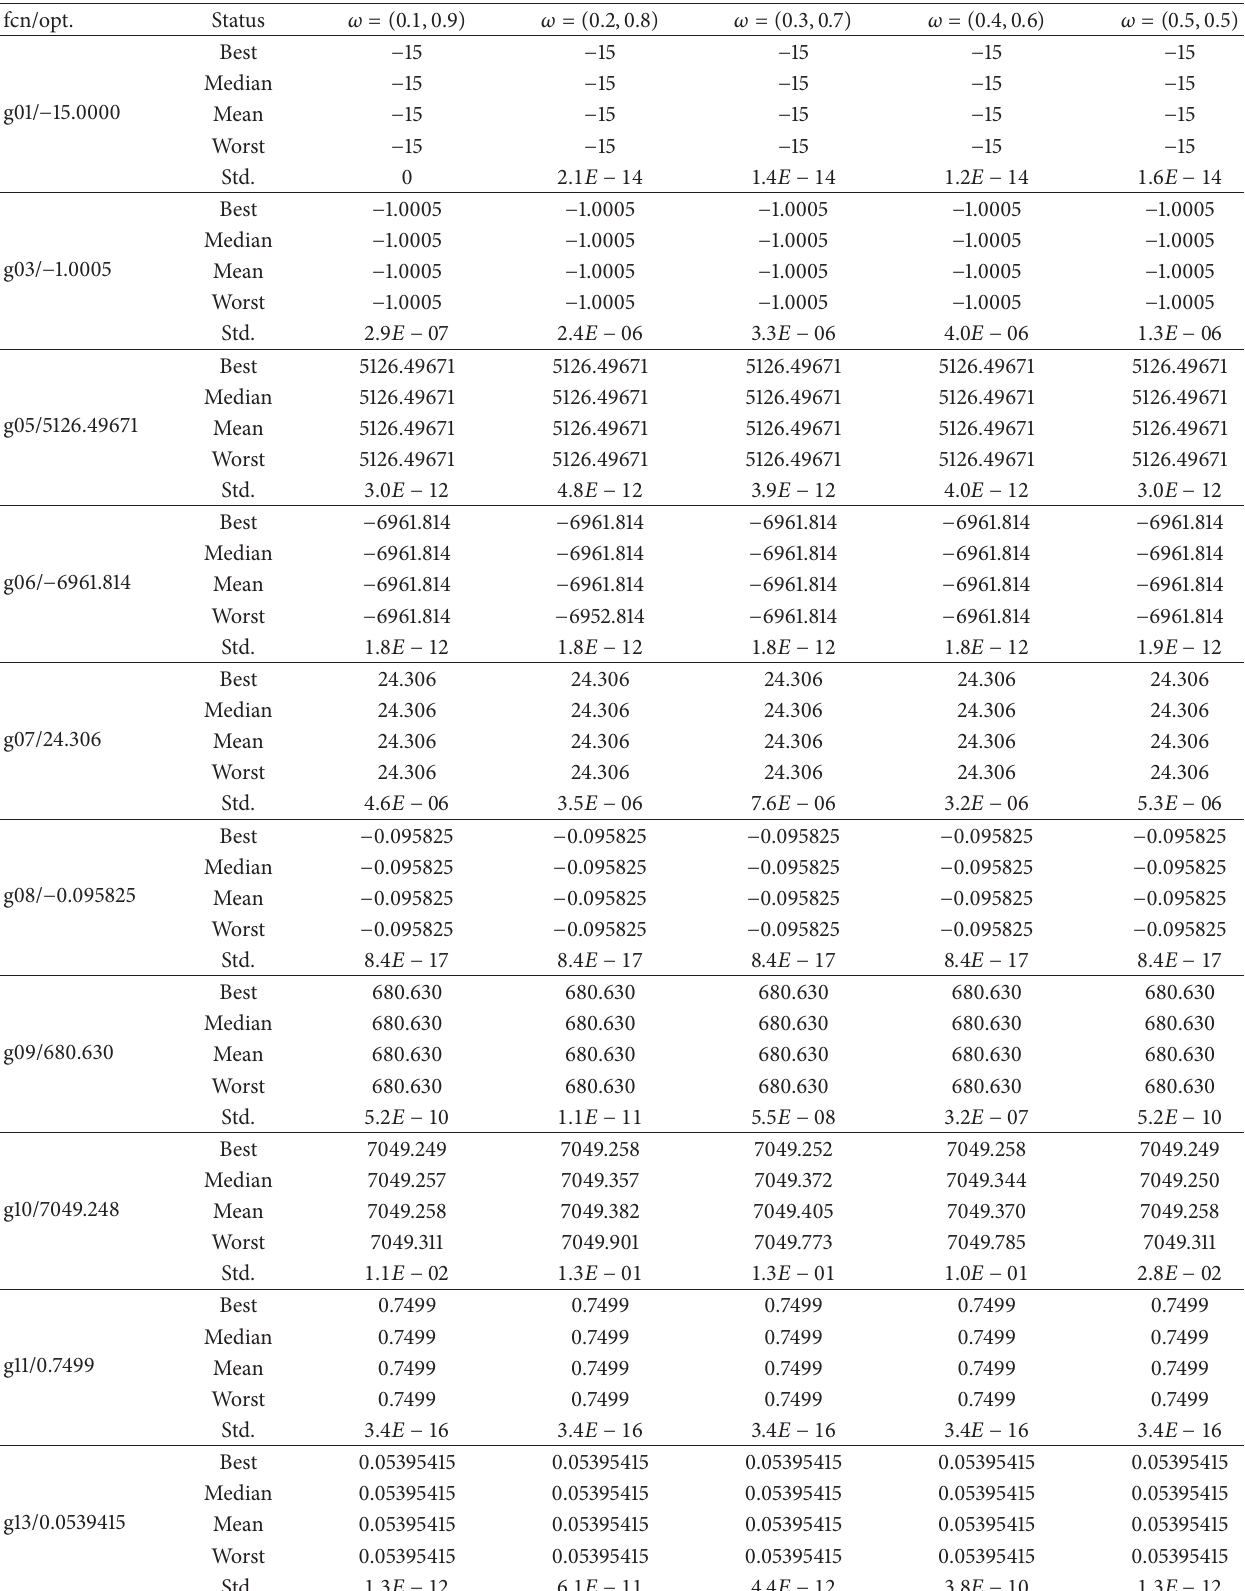
Table 5: Statistical results obtained by MDEDP for 10 among 13 test functions over 30 independent runs with different weighting vectors in stage